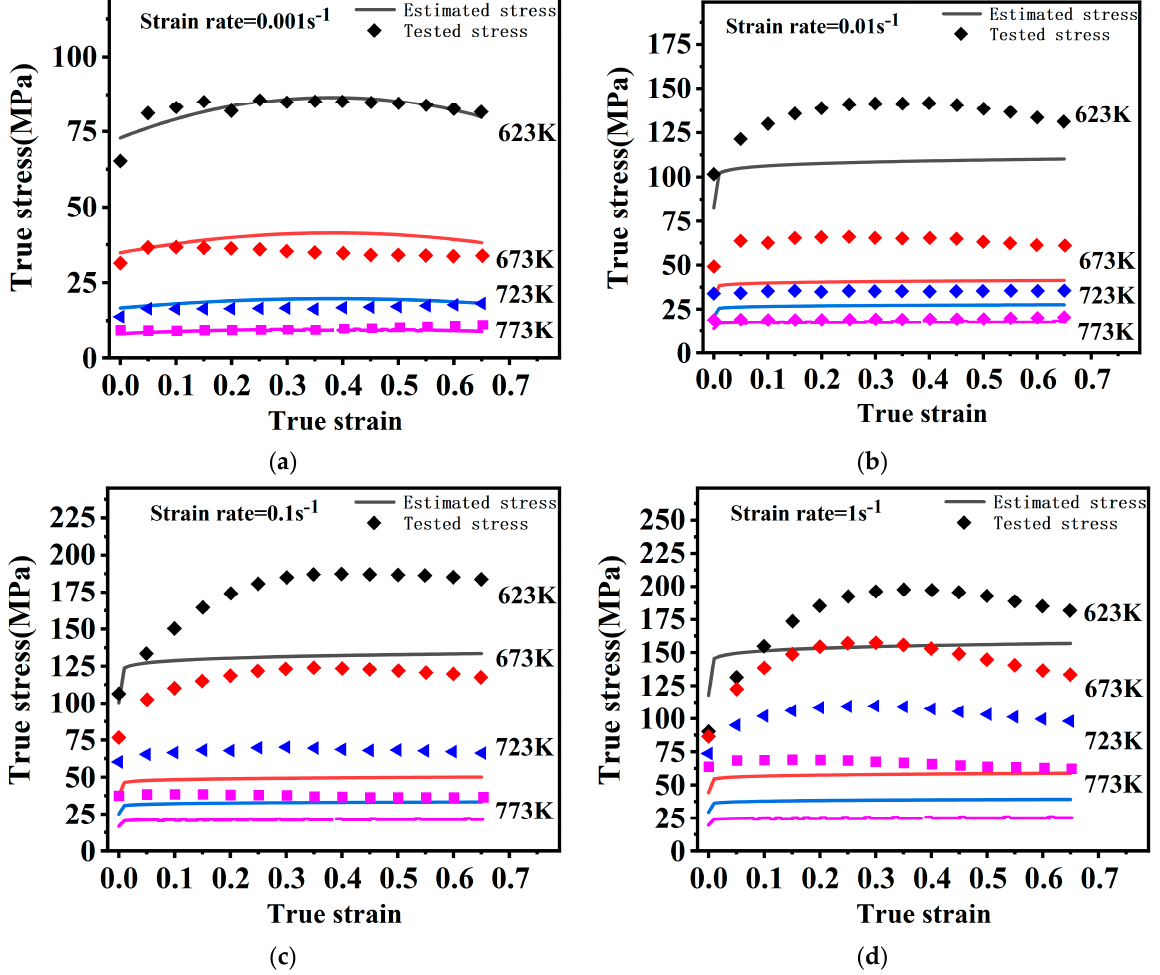
Figure 7. Tested stress and estimated stress by the O–JC under di ff erent conditions. ( a ) 0.001 s − 1 , ( b ) 0.01 s − 1 , ( c ) 0.1 s − 1 , ( d ) 1 s − 1 .